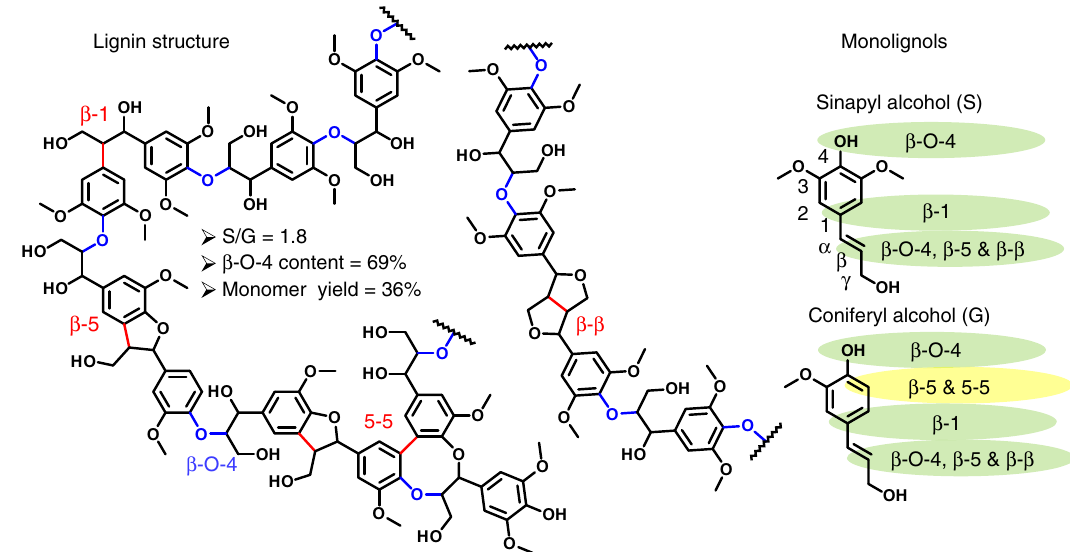
Fig. 1 Lignin structure overview. The two primary monomers, sinapyl alcohol and coniferyl alcohol, shown with the different reacting carbons highlighted with the appropriate C – O or C – C bonds that can form. A hypothetical lignin structure is shown with each type of bond as well as the calculated S/G ratio, β -O-4 content, and monomer